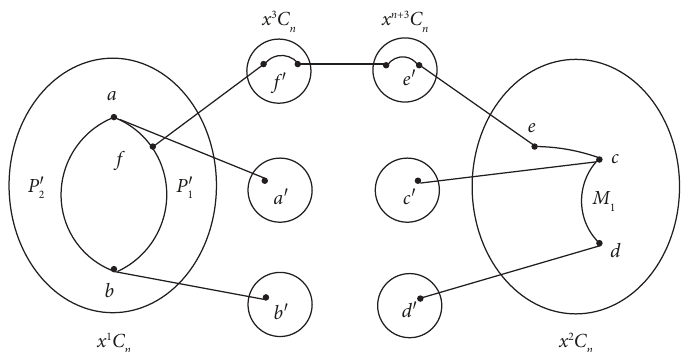
Figure 4: Te illustration of subcase 2.2 of Teorem 1.